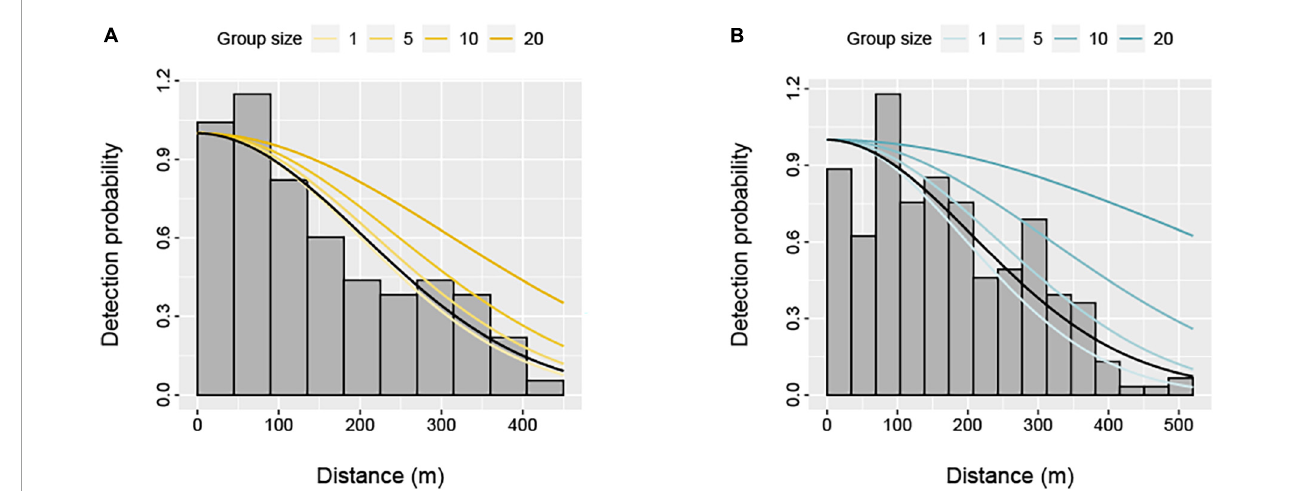
FIGURE2 Distribution of perpendicular detection distances for (A) humpback dolphins ( Sousa saluhensis ) and (B) bottlenose dolphins ( Tursiops aduncus ) during aerial surveys of the Pilbara region. Fitted half-normal detection functions for selected dolphin group sizes (included as a covariate) are shown as solid lines. The black line represents the average detection